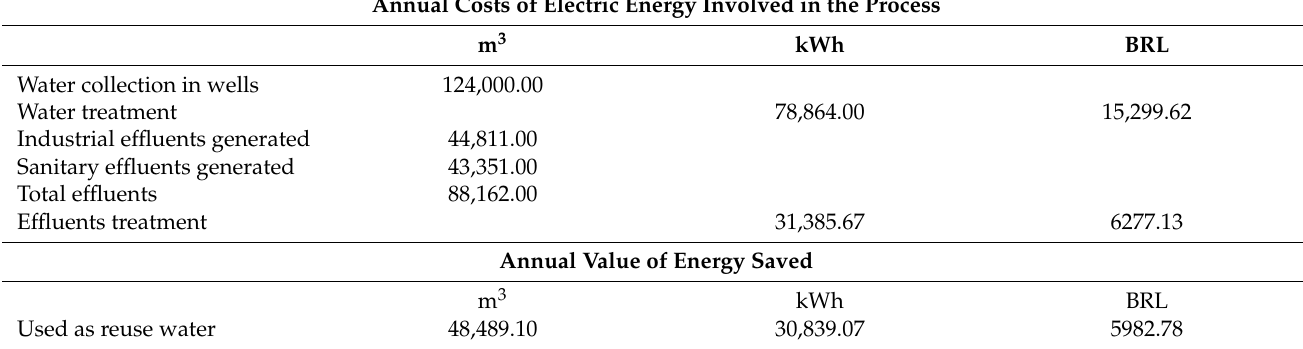
Table 5. Annual costs (BRL) with electric energy.